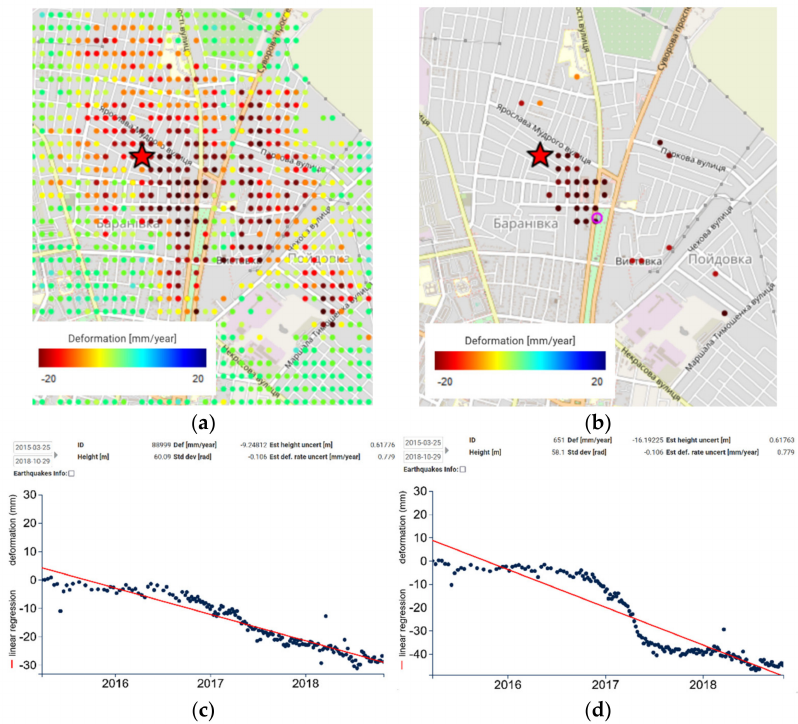
Figure 6. Types of motion detected from temporal classification. ( a ) Map of PS targets; ( b ) subset of PS targets affected by displacement rate changes; ( c ) quasi-linear displacement rate; ( d ) variable displacement rate of the point indicated by the magenta circle.